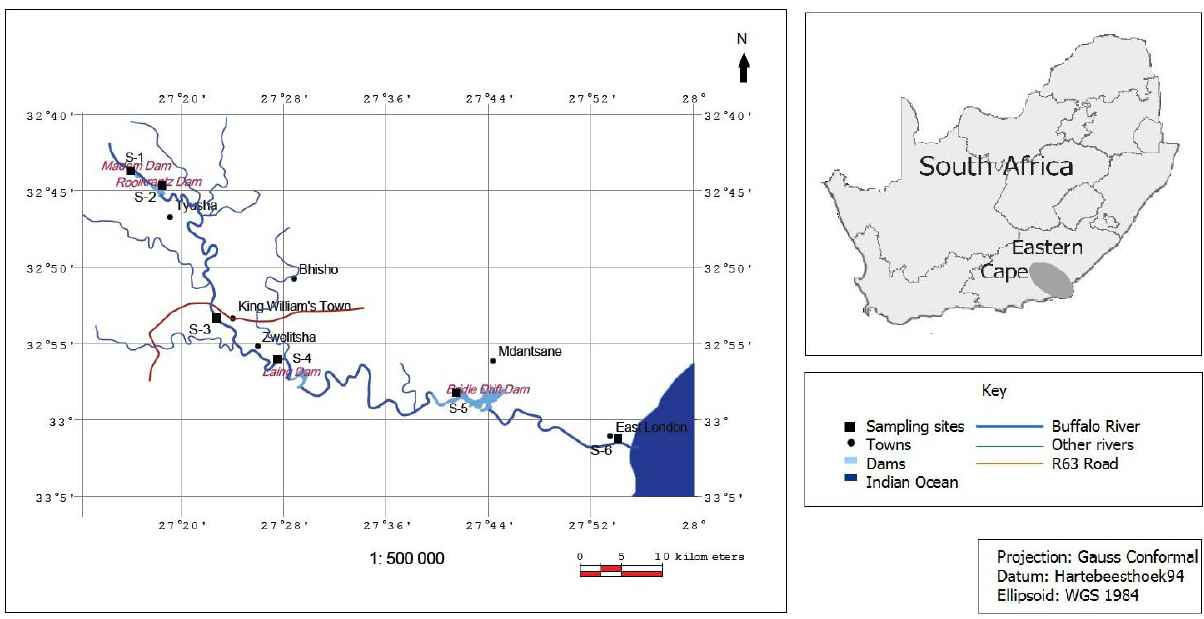
Figure 1. The study area and sampling